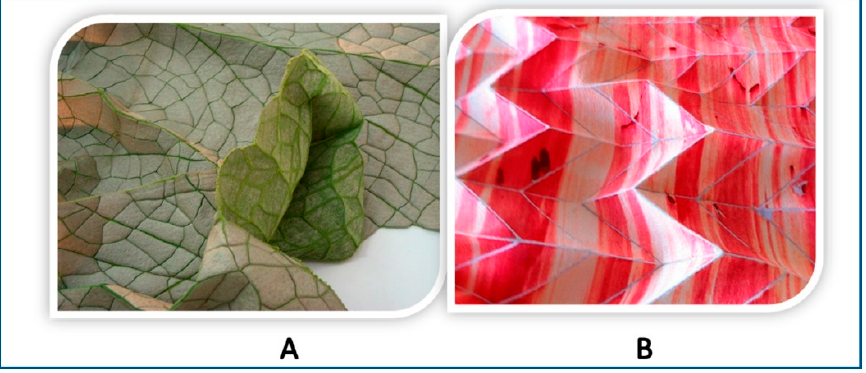
Figure 5. ( A , B ) 3D textiles produced by StartUp Fashion [46].